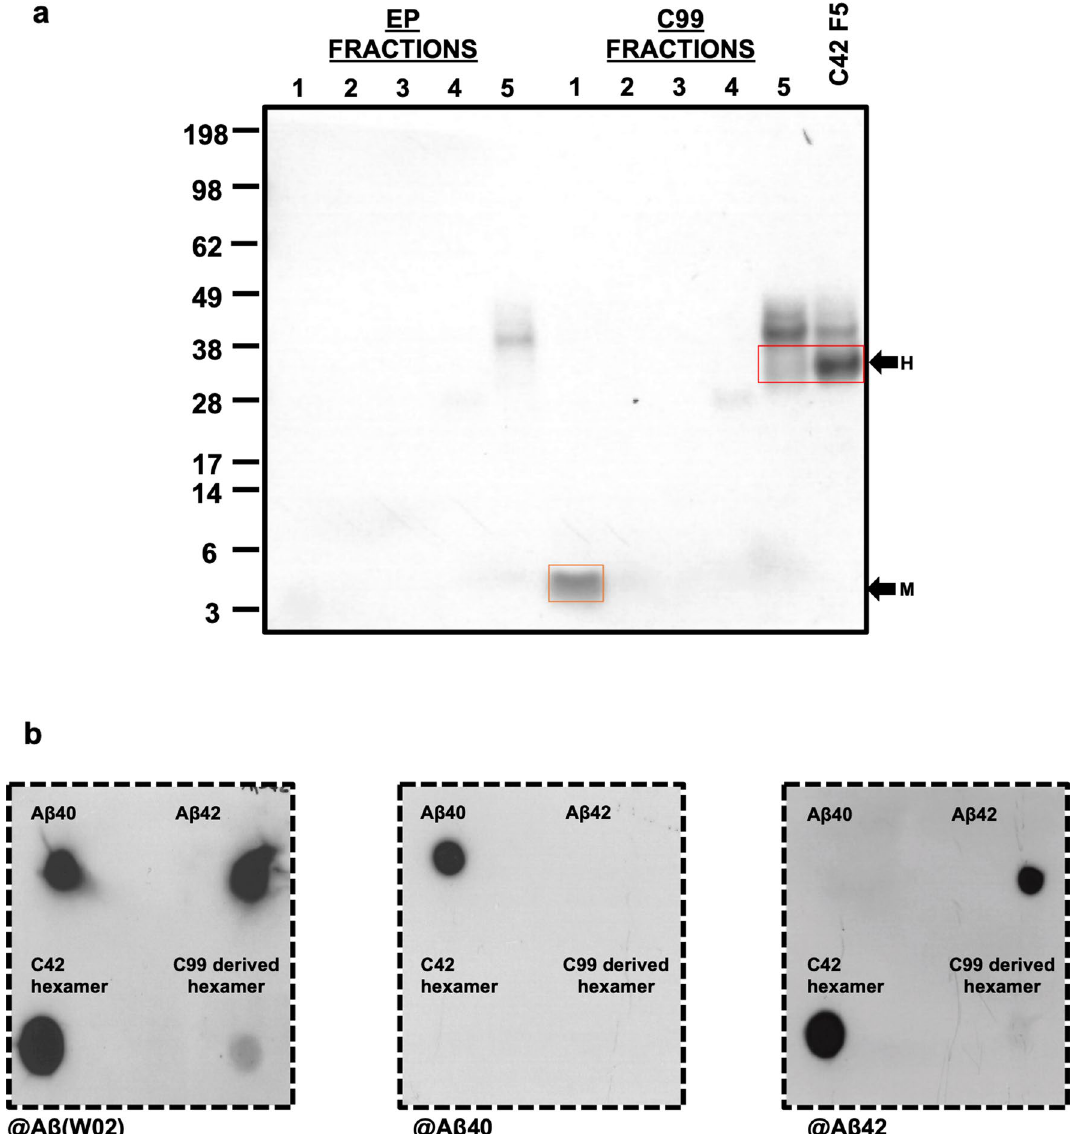
Figure 2. Isolation of Aβ assemblies and identification of hexameric assembly Aβ isoform. ( a ) Aβ was immunoprecipitated using the W0-2 antibody and separated by size using the GELFrEE 8100 system. CHO cells transfected with the empty plasmid (EP) and immunoprecipitated for Aβ did not show isolated assemblies in any fraction. From C99 transfected CHO cells, we are able to isolate monomeric Aβ (orange box) in Fraction 1 and hexameric Aβ (red box) in Fraction 5 (F5). Only hexameric Aβ was isolated (Fraction 5) from C42 transfected CHO cells. ( b ) Dot blotting was carried out to identify the hexameric Aβ isoform using the W0-2, anti-Aβ40 and anti-Aβ42 antibodies. Synthetic Aβ40 and Aβ42 were used as positive controls. Both C42 and C99 derived Aβ hexamers are detected by the anti-Aβ W0-2 antibody (left panel) and anti-Aβ42 antibody (right panel), however, not by the anti-Aβ40 antibody (middle panel) confirming the hexamers are composed of Aβ42. Dashed border indicates the membrane was cut before Isolated hexameric Aβ42 does not self‑assemble into higher molecular weight assemblies. In order to establish the self-assembly properties of the isolated hexameric Aβ42 derived from media of C42 and C99 transfected CHO cells (Fraction 5 shown in Fig. 2a), we first carried out a ThT fluorescence assay as a meas- ure of fibril formation. 150 µM of hexameric Aβ was incubated with 20 µM ThT and fluorescence was monitored over 48 h. Figure 5a shows that over this time course, there is no increase in fluorescence seen which suggests that the hexameric assembly does not form fibrils in the timeframe of our experiment. To further consolidate this and detect any pre-fibrillar assemblies that may not bind to the ThT dye, western blotting was carried out on the same samples at several time points (Fig. 5b and c). Detected by the W0-2 antibody, we see there are no higher molecular weight assemblies at longer time points and only the hexameric assembly is detected for C42-derived hexamers. This also confirms that there is no degradation or disassembly of the peptide. However,